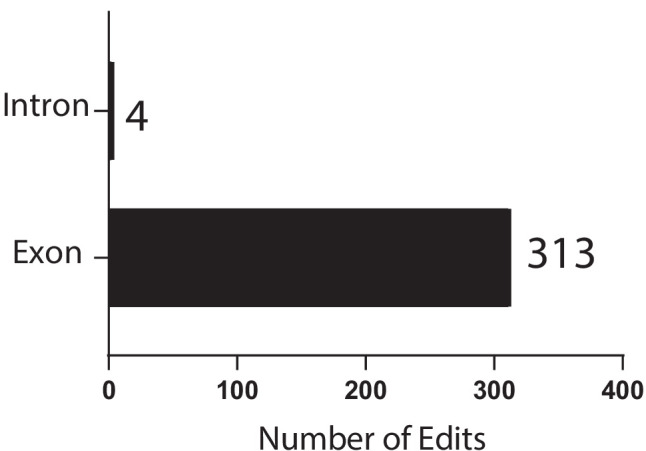
Exon specificity of Atx2 mRNA interactions and sequence selectivity of observed Atx2–coding sequence (CDS) interactions.Atx2-ADARcd fusion protein exclusively edits exons, indicating cytoplasmic binding to mature mRNAs.